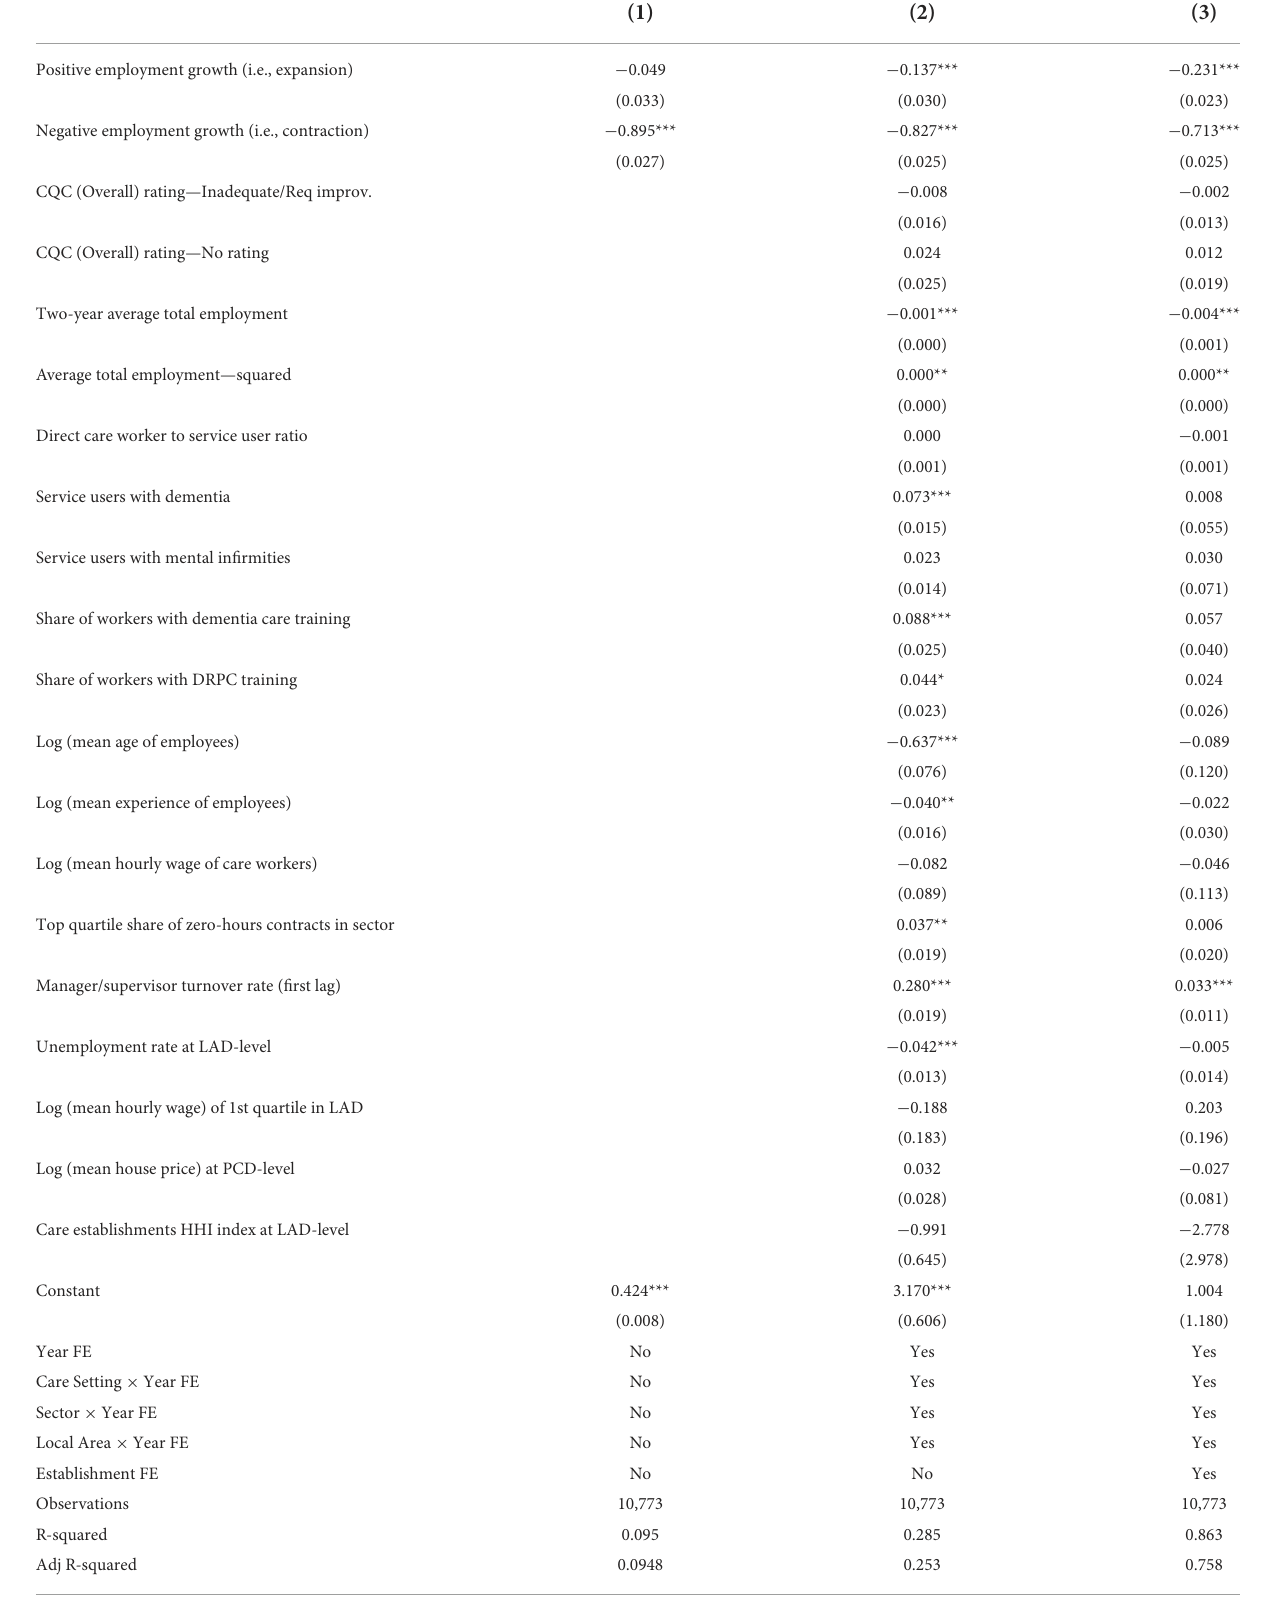
TABLE 3 Estimation results—turnover